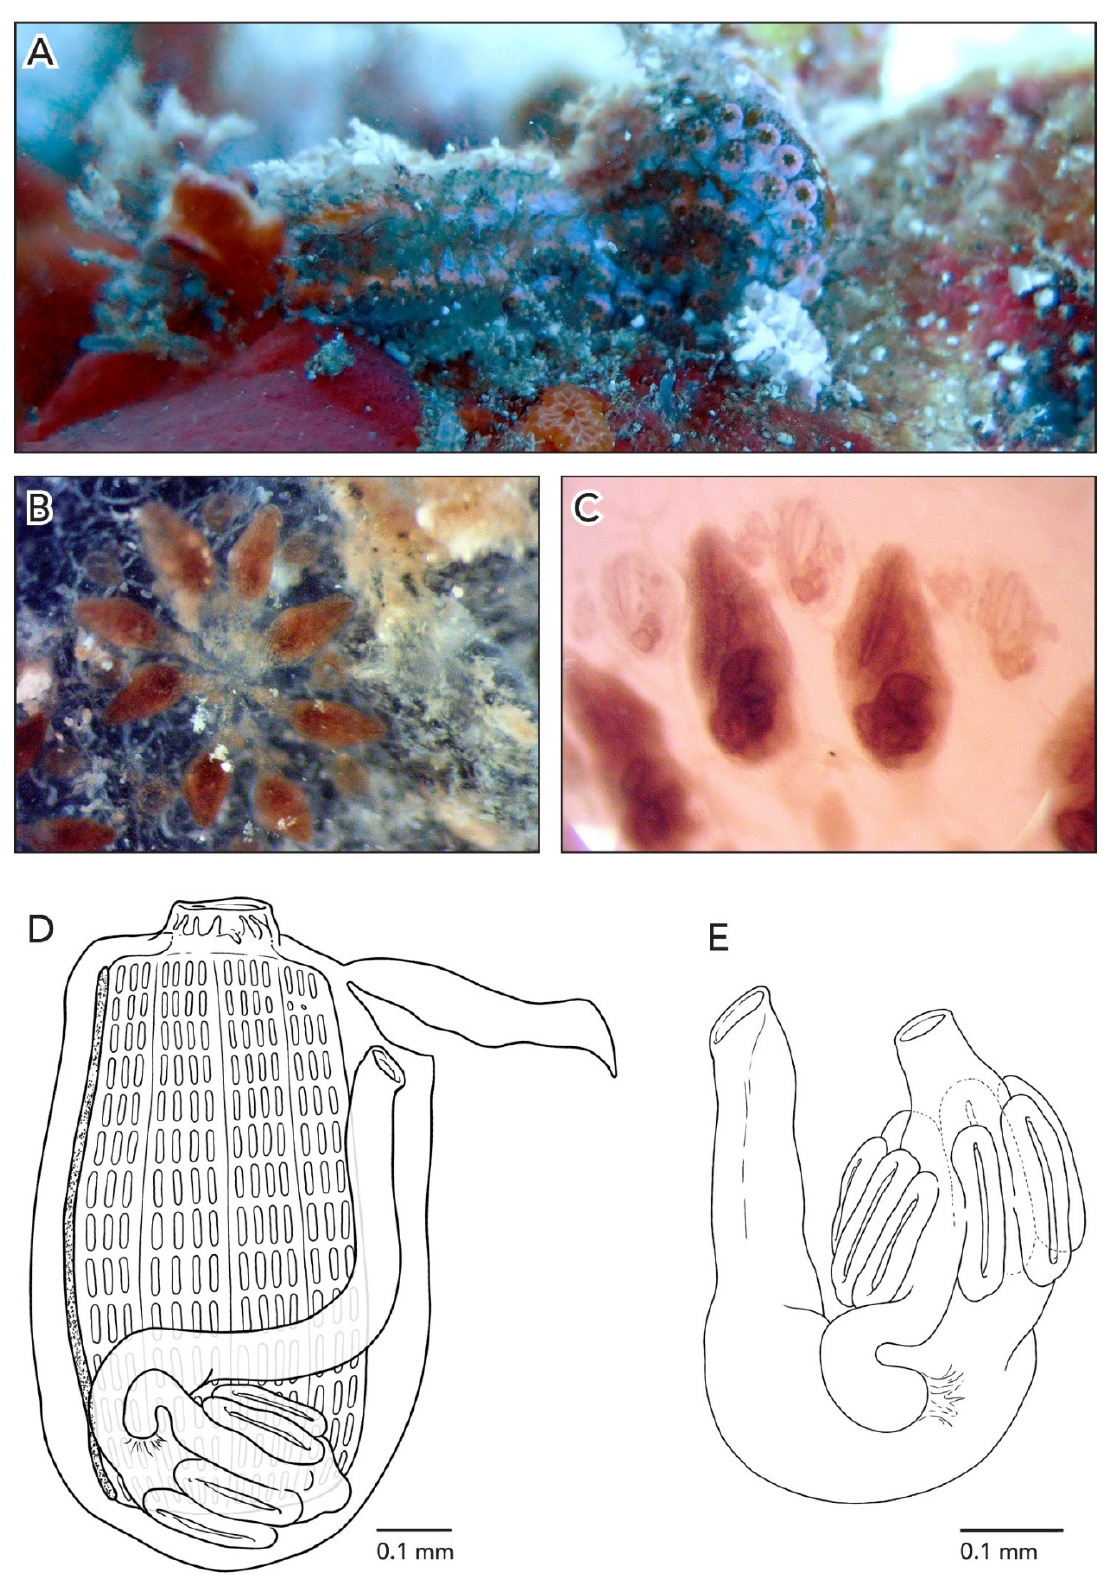
Figure 4. Botryllus camur sp. nov. ( A ) Live colony on natural substrate (Dead coral) ( B ) Organization of one system with eight zoooids ( C ) Zooids and buds in a preserved colony ( D ) Left side view of a zooid ( E ) Detail of the abdomen region.